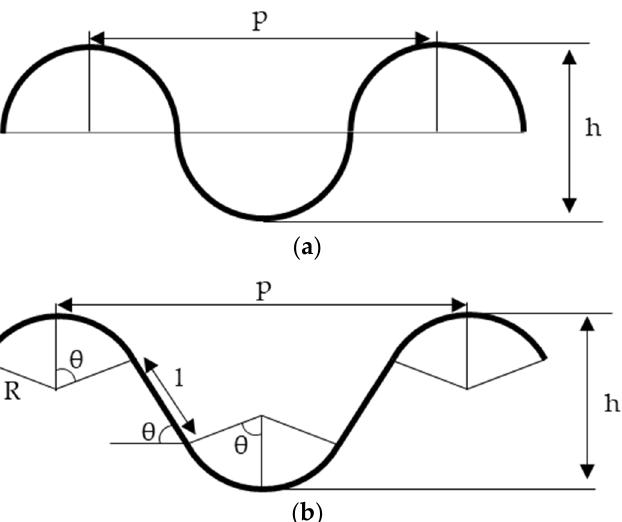
Figure 4. Geometric models for stretchability: ( a ) conventionally used sine-wave-based model; ( b ) a model close to the geometry of the proposed method.